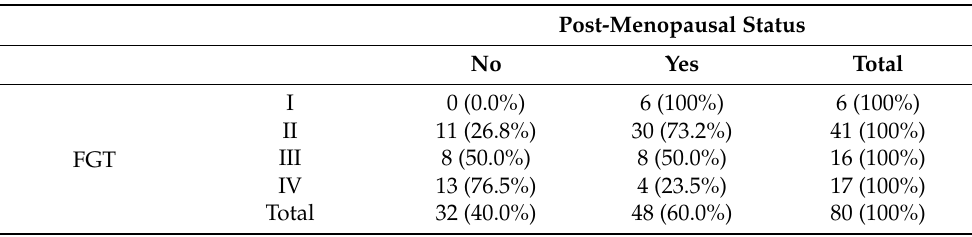
Table 2. Absolute frequency distribution (percentage) of fibroglandular tissue (FGT) of patients undergoing neoadjuvant chemotherapy (NAC) compared to menopausal condition.